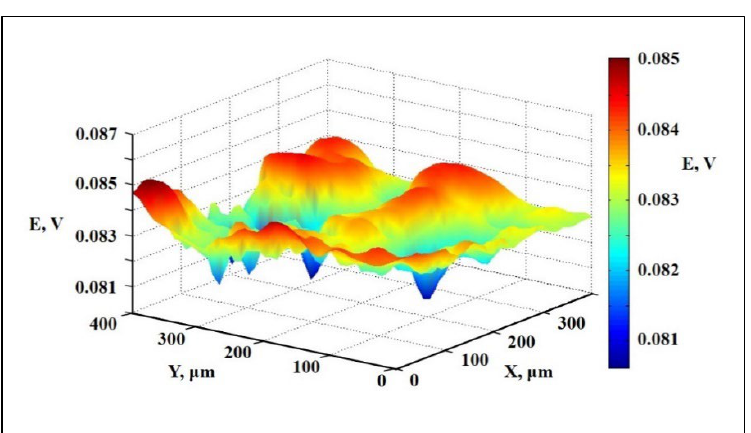
Figure 16. Topography of potential distribution near the surface of the CMX membrane ( a ) and optical images of cross sections of the dry and swollen CMX membrane ( b ); the threads of reinforc- ing cloth are seen as light lines. Measure d is the true membrane thickness, d app is the apparent thickness determined using a micrometer, and b is the distance between the top of a hill and the bottom of a valley on the surface. Adapted from [120].